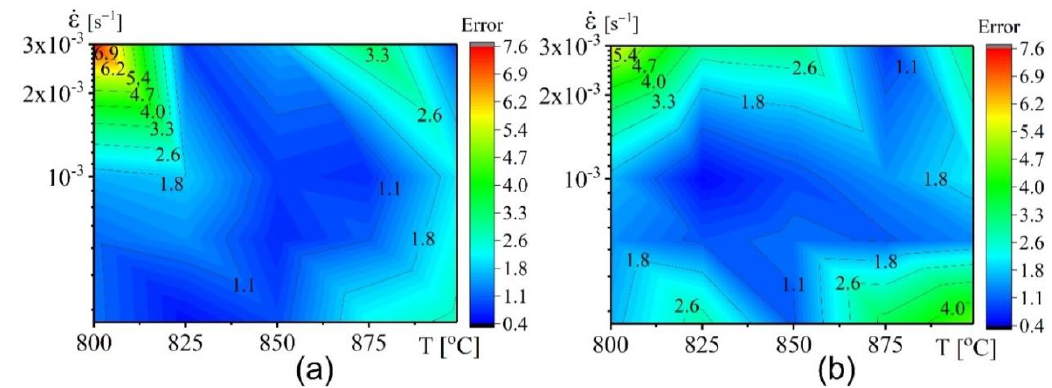
Figure 13. The error between experimental and tested flow stress after cross-validation of ( a ) power law model and ( b ) hyperbolic sine law model .